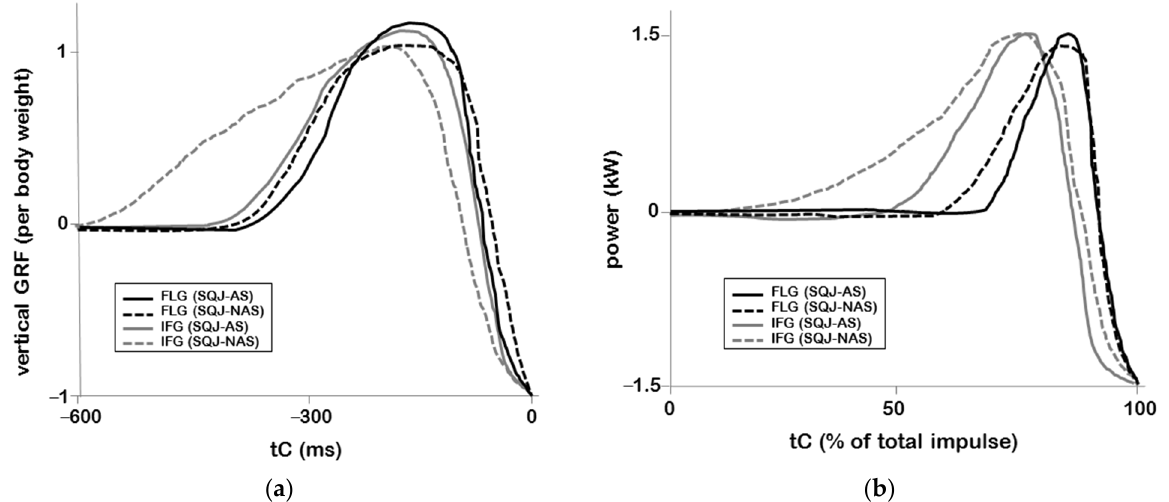
Figure 2. Representative individual time history curves for ( a ) vertical ground reaction forces (tC = 0 indicates the instant of take-off); ( b ) power output. Dashed lines present the squat jump test without an arm swing (SQJ-NAS) and solid lines the squat jump test with an arm swing (SQJ-AS). Black lines depict a flexible player (FLG) and gray lines an inflexible player (IFG).